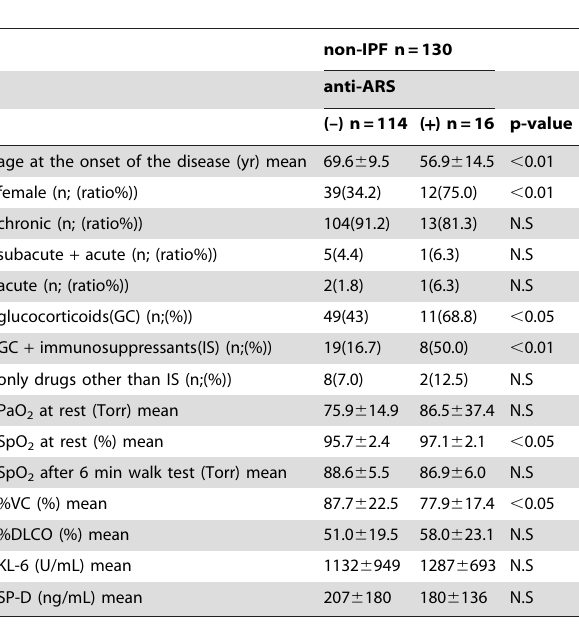
Table 4 Comparison of clinical backgrounds between anti- ARS ( + ) and ( 2 ) non-IPF patients.